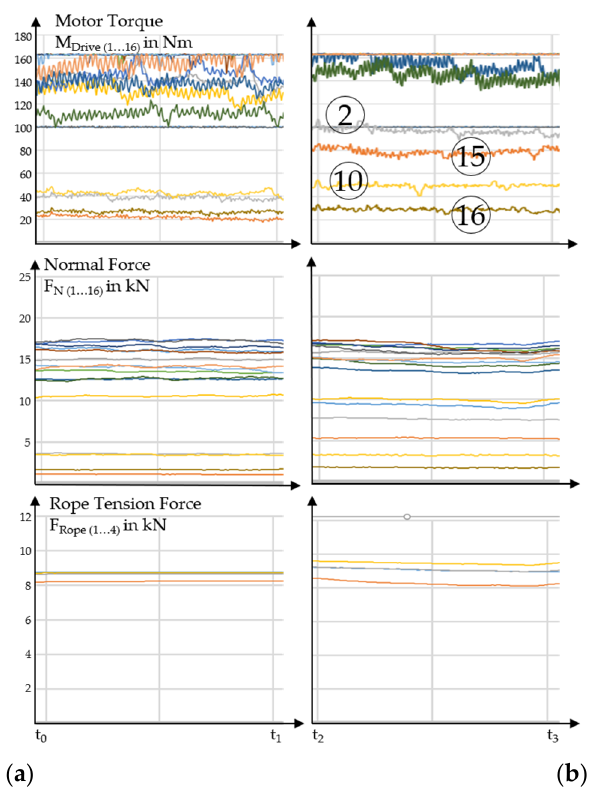
Figure 10. Experimental data from CCR: without cantilever arm ( a ); with cantilever arm ( b ).